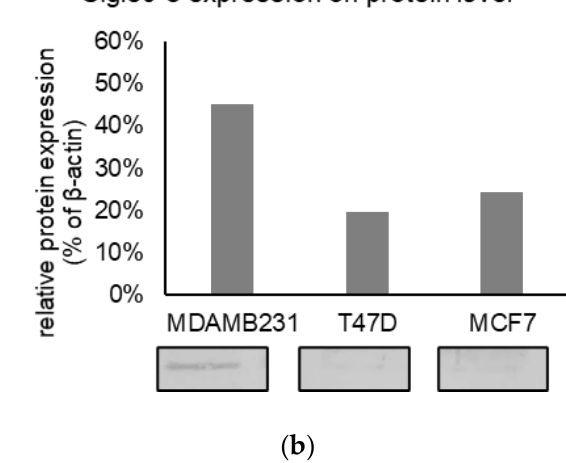
Figure 7. Mean relative Gal-7 expression on mRNA level (calculated with the 2 −ΔΔCT method) in MCF7 cells dependent on Siglec-8 silencing. Expression in control cells is displayed and expression in cells, where Siglec-8 was silenced with 5 nM siRNA A, B and C for 48 h, is normalized on the expression in control cells. GAPDH was used as endogenous control for ΔCT-values and the results are means of triplicates. siRNA A and siRNA B led to significantly reduced Gal-7 expression. 2.4.3. Siglec-8 mRNA Expression after Stimulation with β-Estradiol and Rosiglitazone As ER status and Siglec-8 expression correlated in the Immunohistochemistry (IHC) analysis, it was examined whether stimulating the ER influences Siglec-8 expression. Stim- ulating the cells with β-estradiol for 24 or 48 h did not result in any differences in the Siglec-8 expression (data not shown). Furthermore, literature research revealed a Peroxisome proliferator-activated recep- tor (PPAR)  -binding site in the Siglec-8 gene in GeneCards [40]. Therefore, the influence of the PPAR  agonist rosiglitazone on Siglec-8 expression on mRNA level was analyzed.